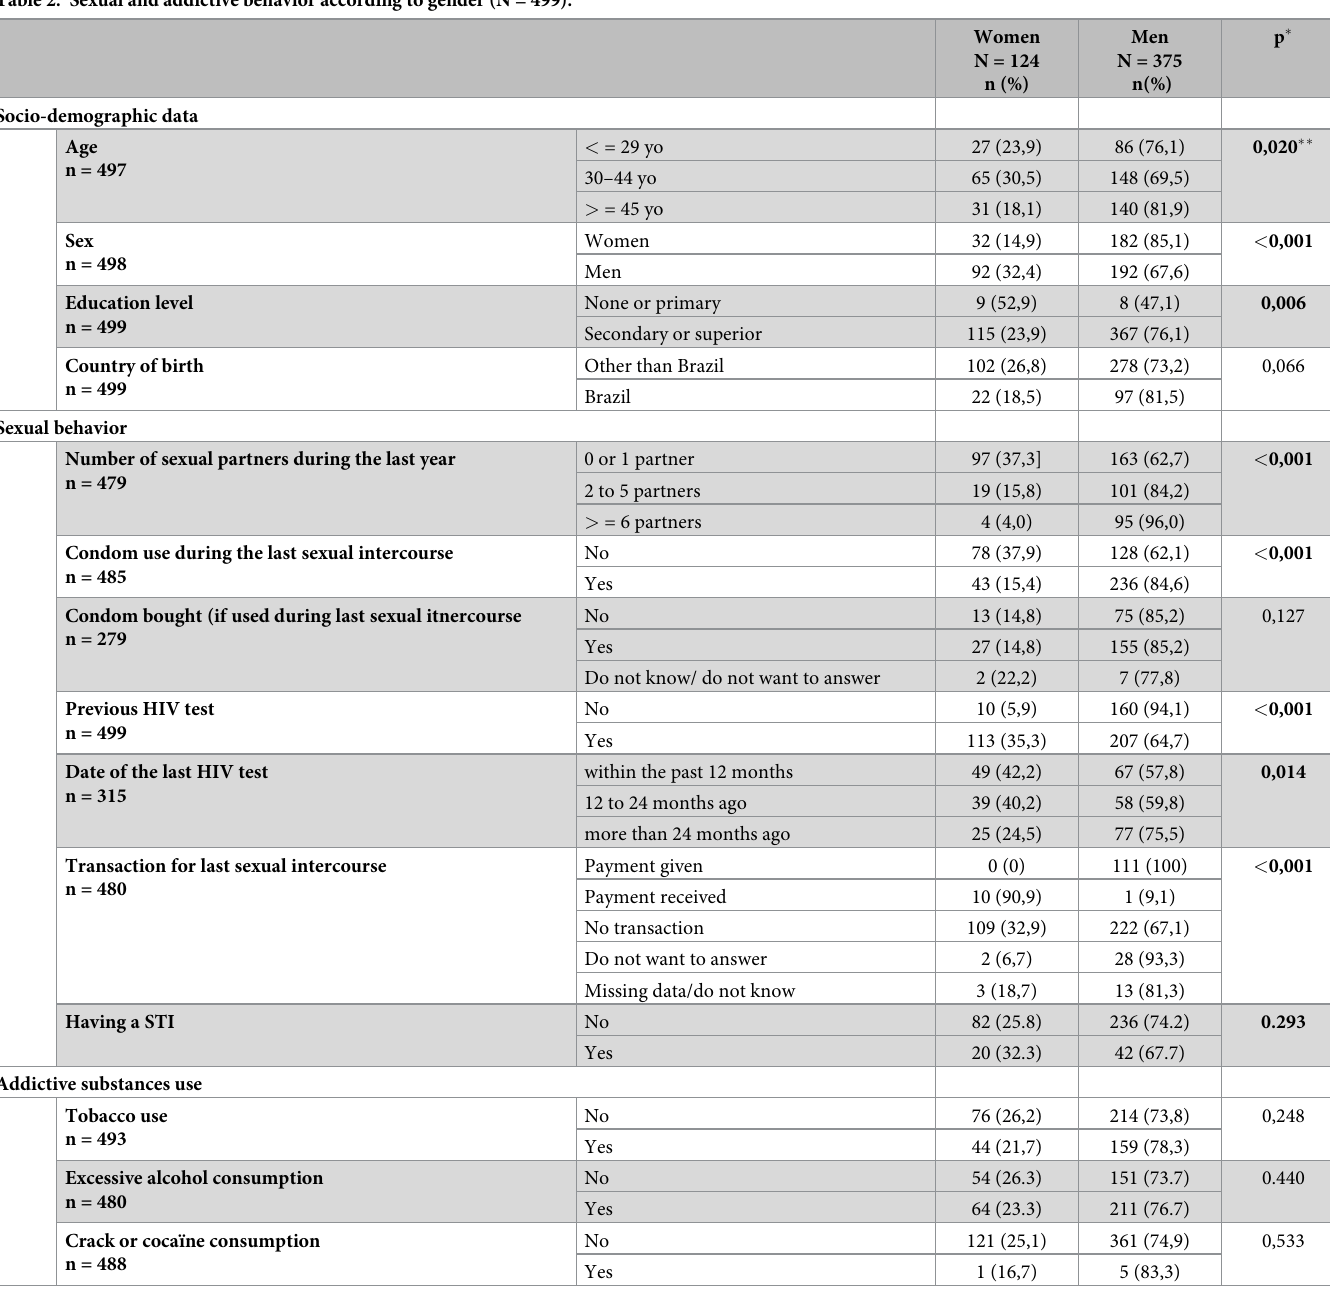
Table 2. Sexual and addictive behavior according to gender (N =